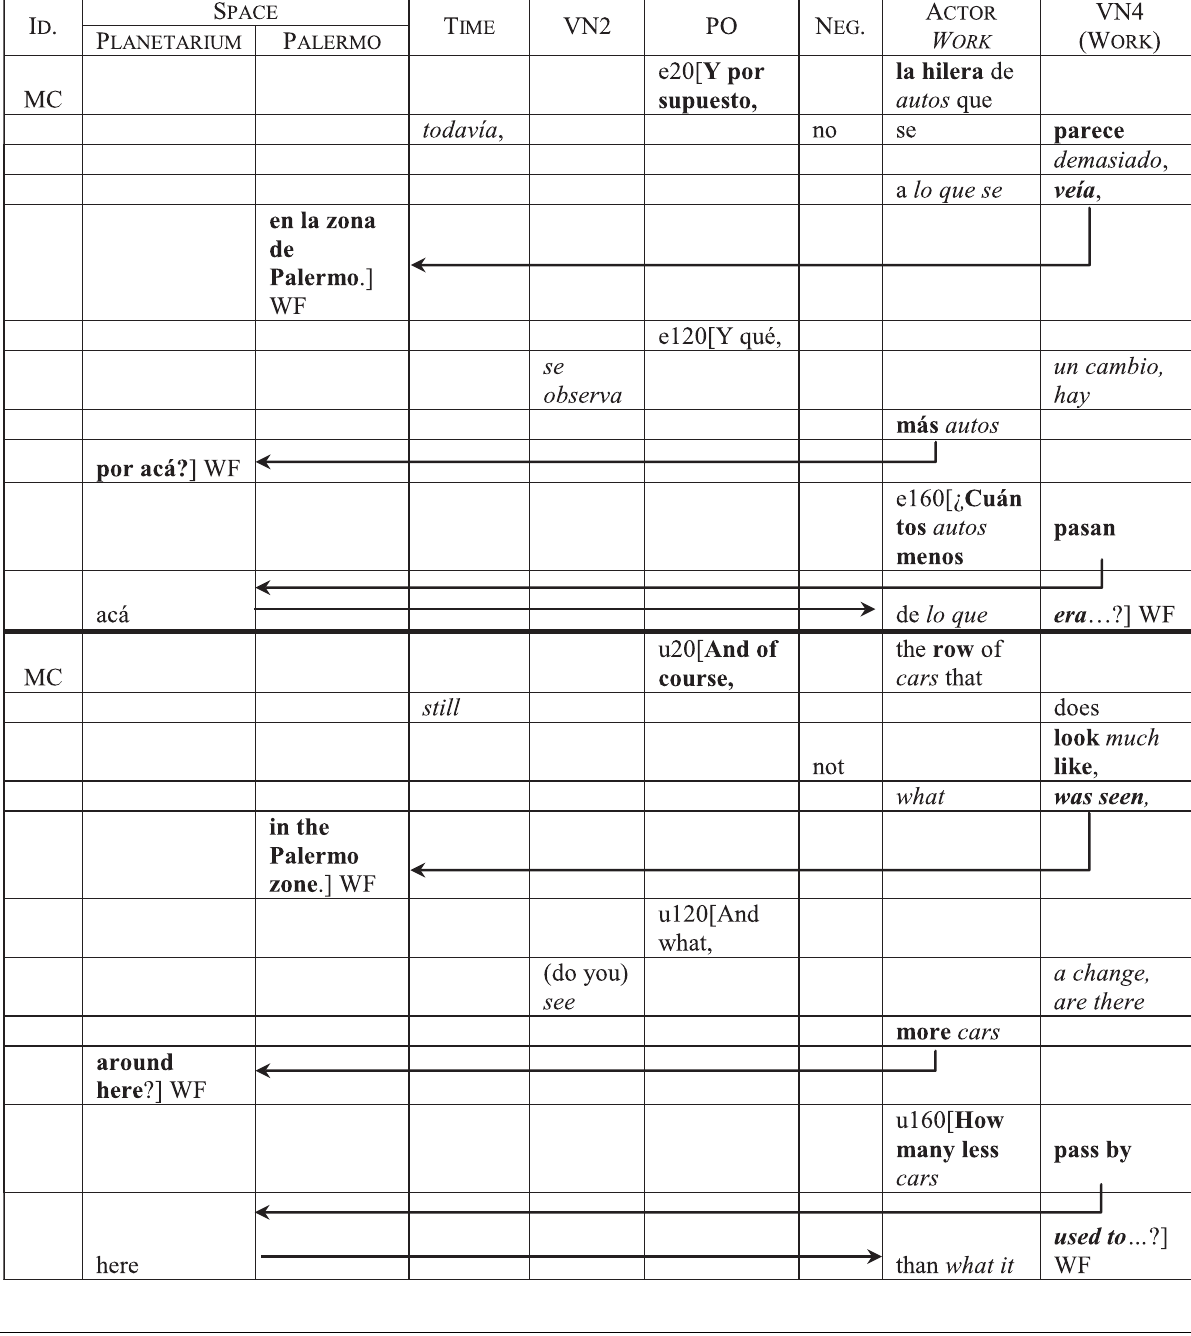
TABLE 4 | Focalization of the Actor Work : economic aspects.